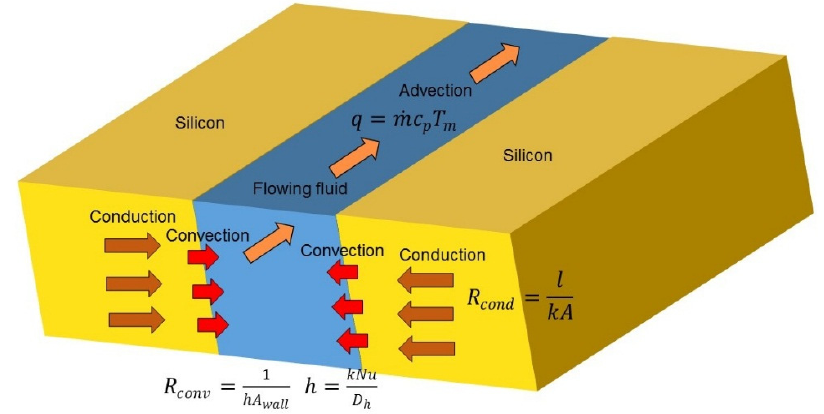
Figure 2. Illustration of the three heat-transport mechanisms in microchannel-cooled chips. See the text for the explanations of the equations.